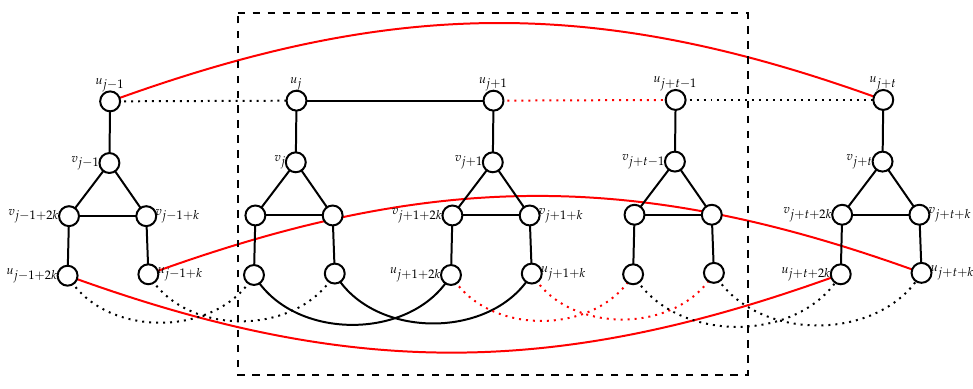
Figure 4. Illustrating Algorithm A for constructing P (cid:48) from P ( 3 k , k ) . Lemma 2. The graph P (cid:48) returned by Algorithm A is isomorphic to P ( 3 k Algorithm 2 (Algorithm